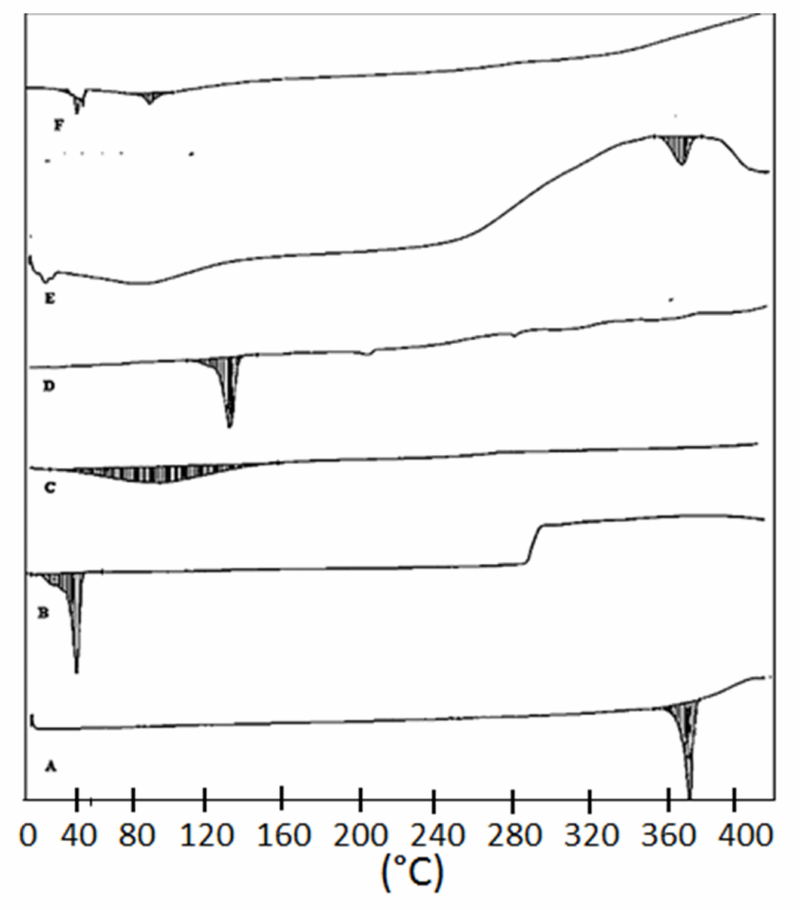
Figure 8. DSC thermogram of ( A ) Apigenin, ( B ) TPGS, ( C ) Chitosan, ( D ) Lecithin ( E ), physical mixture, ( F )